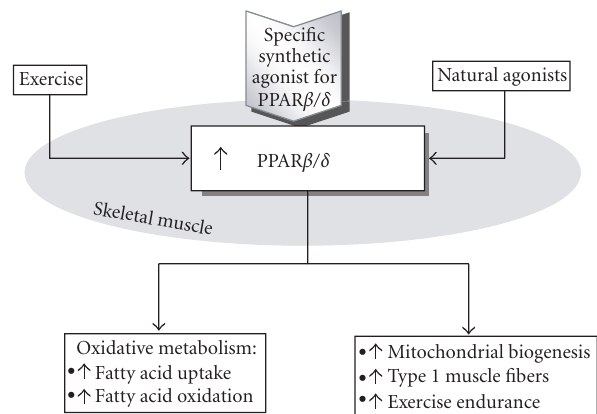
Figure 1: Di ff erent type of activators such as exercise and natural ligands but particularly specific synthetic agent activates PPAR β / δ in skeletal muscle and strengthens the mitochondrial apparatus and potential to oxidize lipids. More fatty acids are pulled into the more oxidative fiber made by the influence of specific agonist. Hence, PPAR β / δ -induced improvements in oxidative capacity and fat uti- lization in skeletal muscle could lead to metabolic